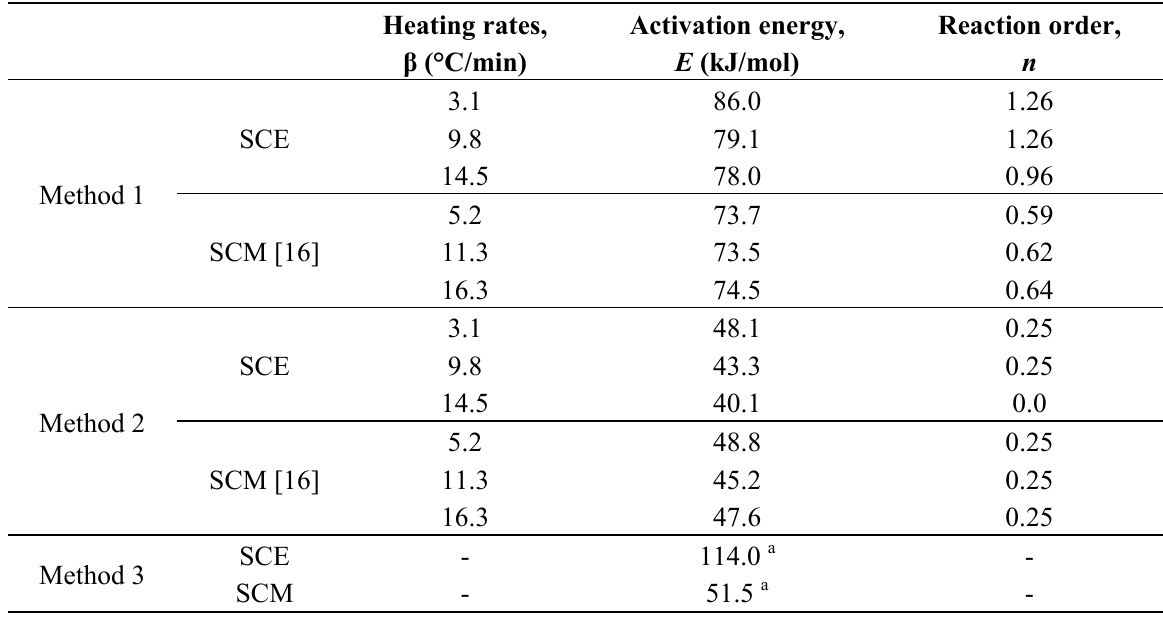
Table 4. Summary of the kinetic parameters obtained from this